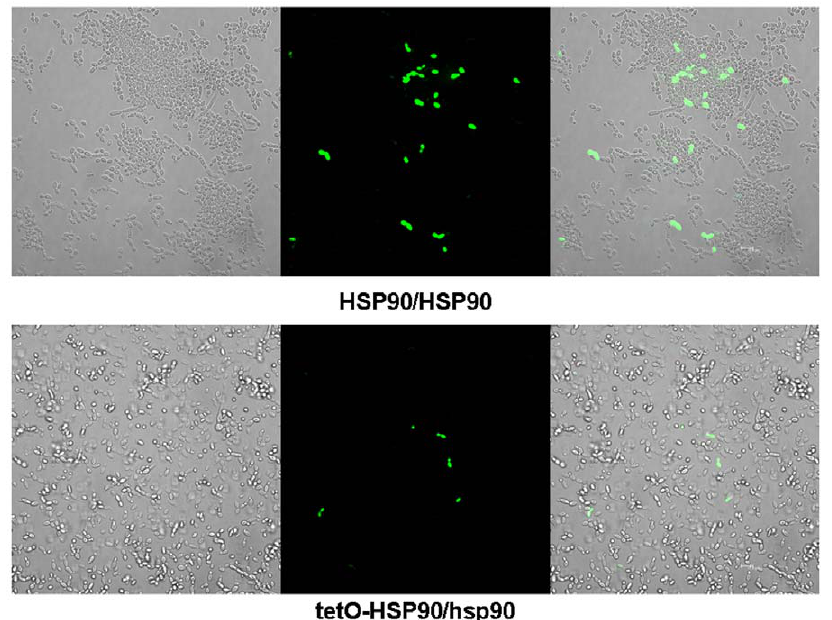
Figure 4. Representative confocal scanning laser fluorescence images of HSP90/HSP90 and tetO-HSP90/hsp90 cells stained for ROS accumulation following exposure to 5 mM H 2 O 2 for 3 h in the presence of DOX. Bar represents 10.8 m m.